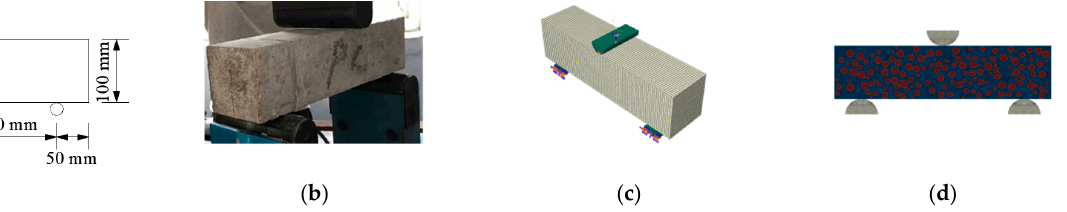
Figure 7. Flexural strength test: ( a ) schematic diagram, ( b ) physical diagram, ( c ) inclusion model, and ( d ) 2D random model.